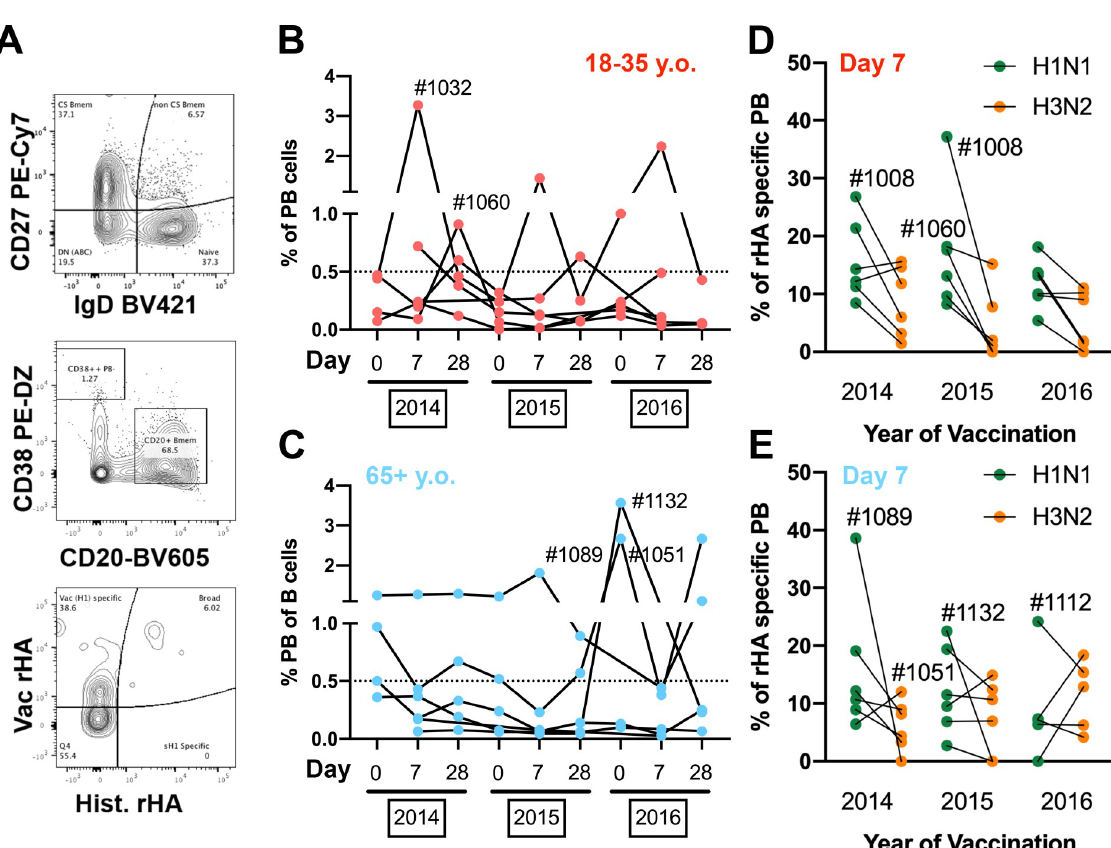
Fig 3. Plasmablast response in young and elderly participants vaccinated for three consecutive years. A) Representative gating strategy to quantify rHA-specific plasmablast (CD27 + /CD38 ++ /CD20 - ) in the peripheral blood of vaccinated participants. B-C) Changes in frequency of plasmablast B-cells in the peripheral blood of young-adult (B) and elderly (C) participants vaccinated over three consecutive years. D-E) Frequency of vaccine-specific (H1N1 in green and H3N2 in orange) plasmablast 7 days post-vaccination in young adult (D) and elderly (E) participants vaccinated for three consecutive years. Participants of interest are identified with the corresponding ID numbers. H1N1 Vac rHA is CA/09 for 2014–16, and H1N1 Hist. rHA are NC/99 and Sing/86 (pooled at half concentration); H3N2 Vac rHA is TX/12 for 2014, Switz/ 13 for 2015 and HK/14 for 2016; H3N2 Hist rHA are Pan/99 and Wisc/05 for